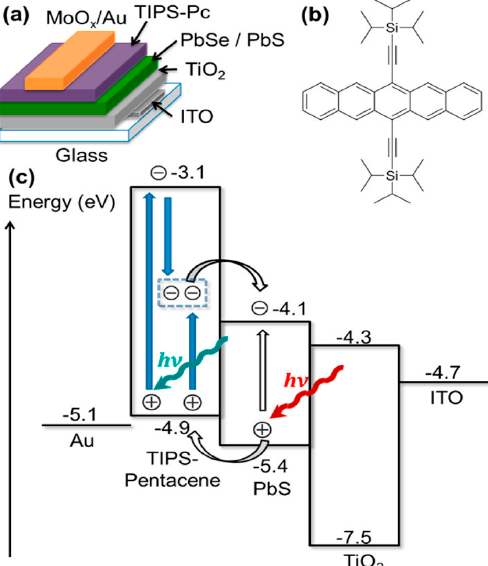
Figure 13. ( a ) Device architecture of the nanocrystal/TIPS − pentacene photovoltaic device. ( b ) Chem- ical structure of TIPS − pentacene. ( c ) Alignment of energy levels in the PbS/TIPS − pentacene device. Reprinted with permission from Ref. [94]. Copyright 2015, American Chemical Society.